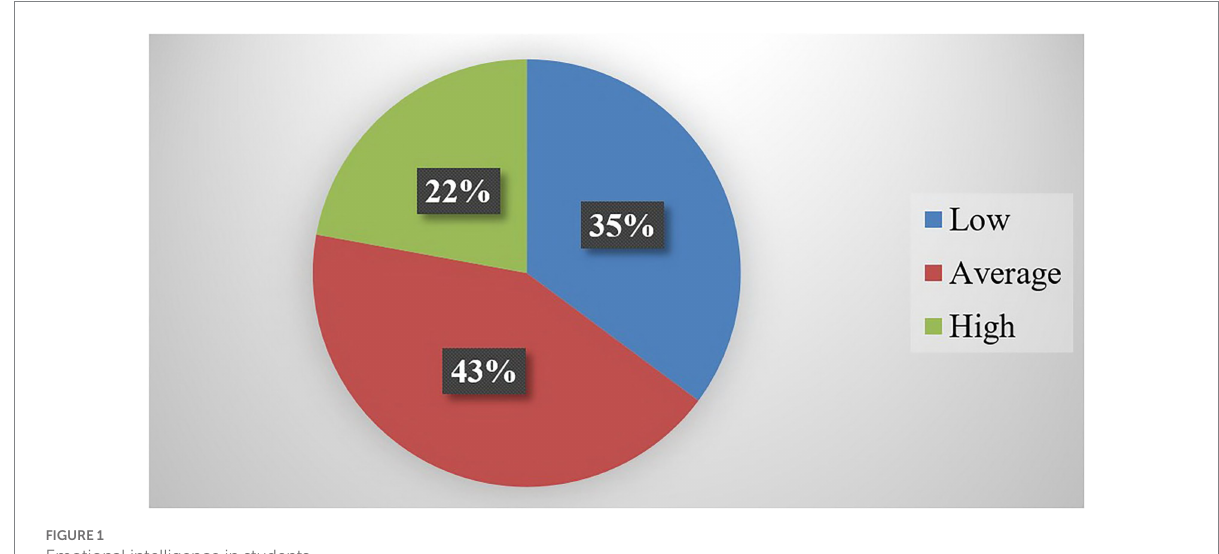
FIGURE 1 Emotional intelligence in students.